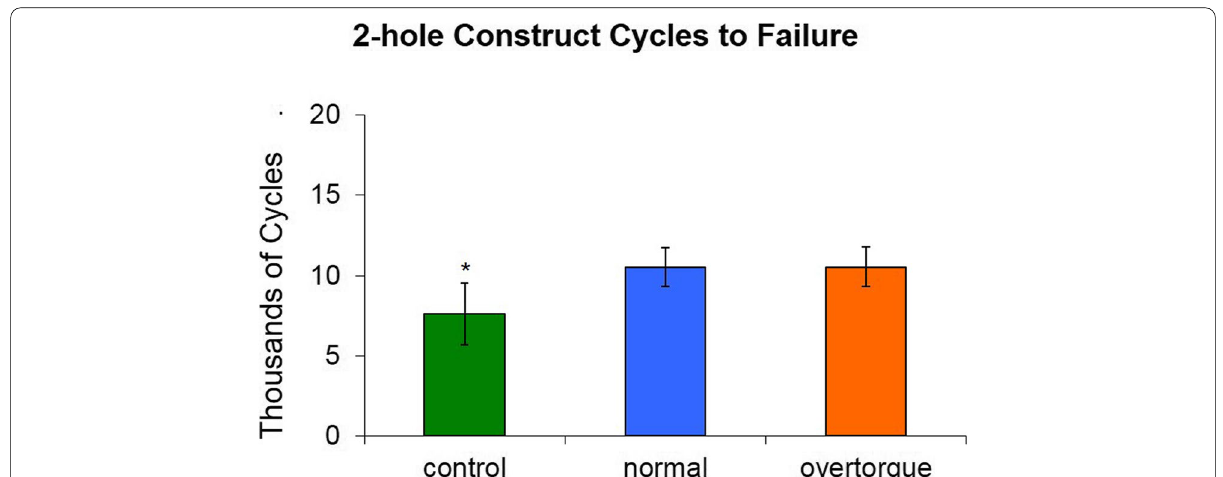
Fig. 4 Average cycles to failure for two-hole constructs (mean standard deviation). Significantly fewer cycles were required to failure in the ± control group versus the normal and overtorque group. No difference was found between the normal and overtorque